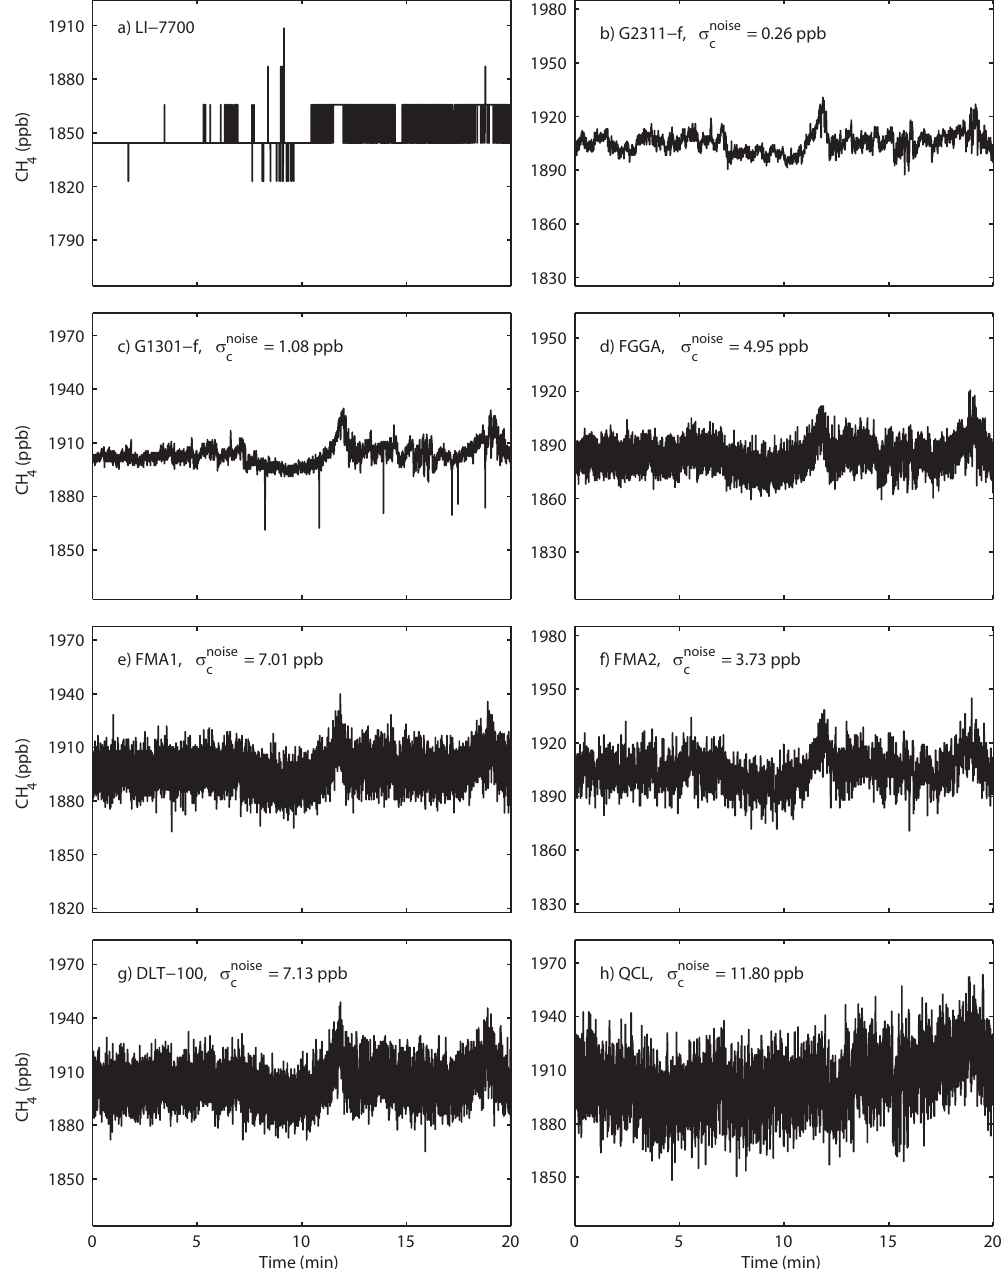
Figure 5. Example of raw CH 4 concentration data from each instrument. Data were measured on 22 June 2012, between 10:40 and 11:00. Corresponding instrumental noise estimates are also shown in the figure, except for LI-7700. The LI-7700 data are clearly affected by the external data-logging problem which is not caused by the